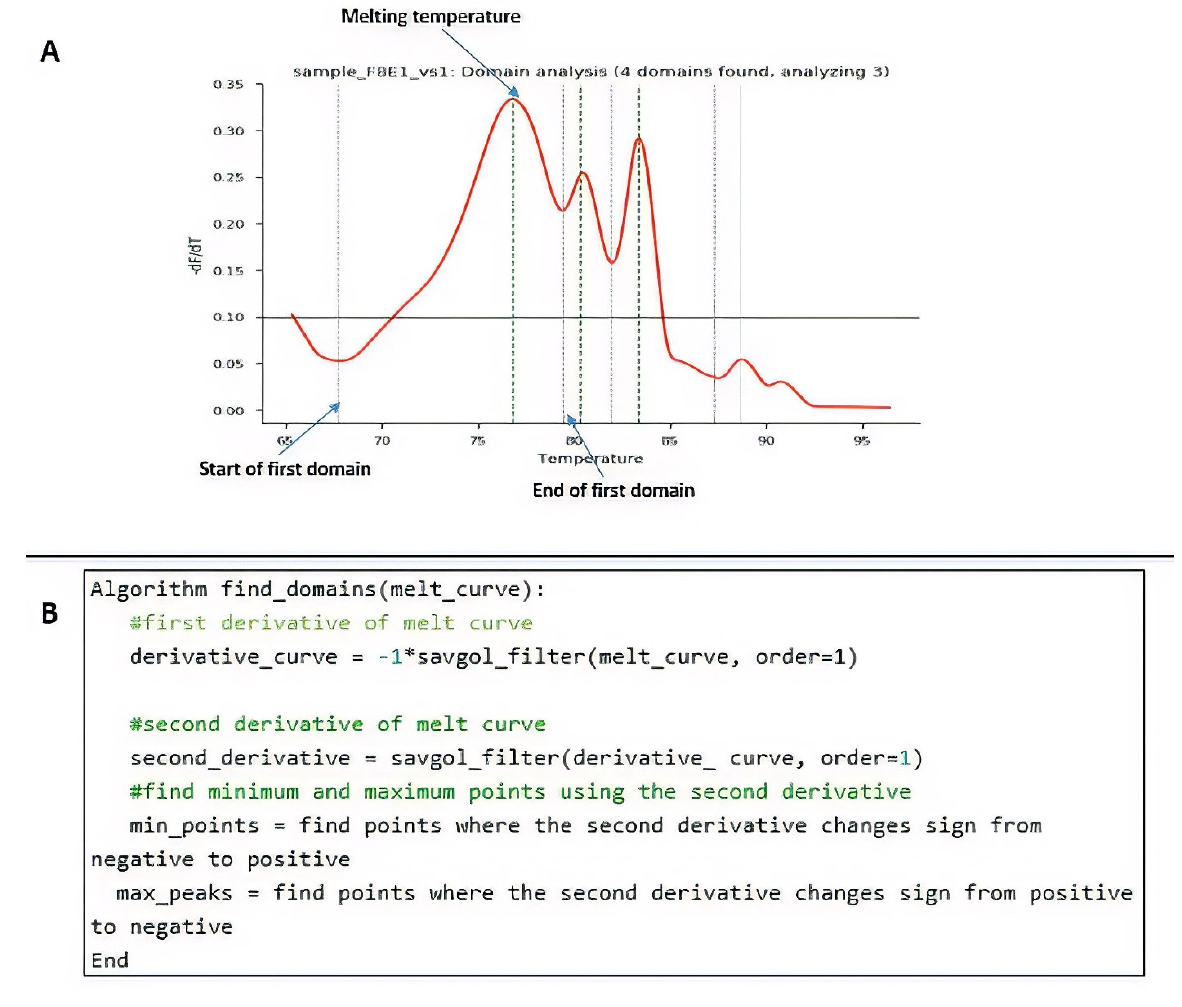
Figure 2. Procedural programming scripts developed in Python. ( A ) Example of peak identification through the algorithm. ( B ) Pseudo-algorithm of the process.